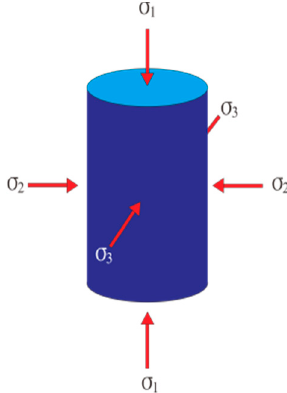
Figure 2. Stress test model.